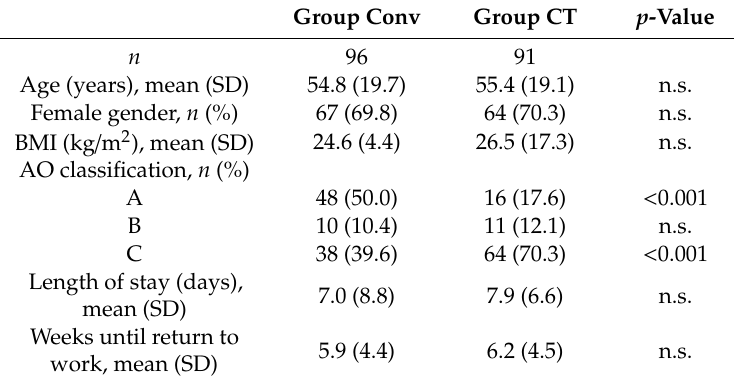
Table 1. Patient demographics.